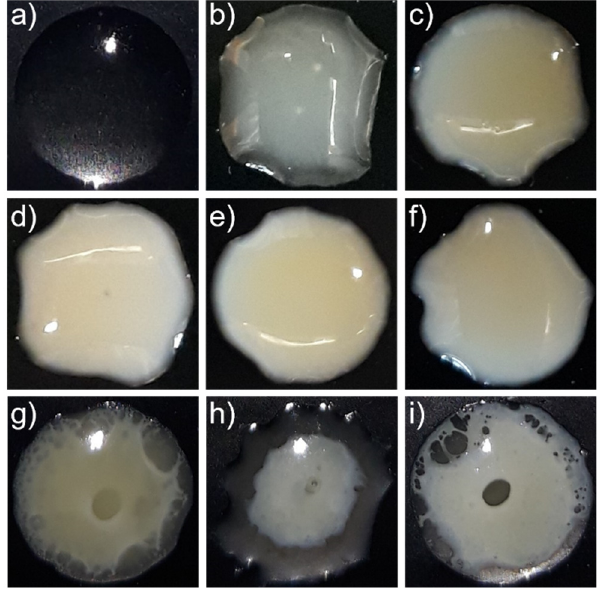
Figure 3. Photographs of ⌀ 8 mm RIT/PVPVA ASDs discs after two days of storage at 25 °C and 97% RH for DLs of ( a ) 0 wt%, ( b ) 5 wt%, ( c ) 10 wt%, ( d ) 15 wt%, ( e ) 20 wt%, ( f ) 25 wt%, ( g ) 30 wt%, ( h ) 35 wt%, and ( i ) 40 wt%.